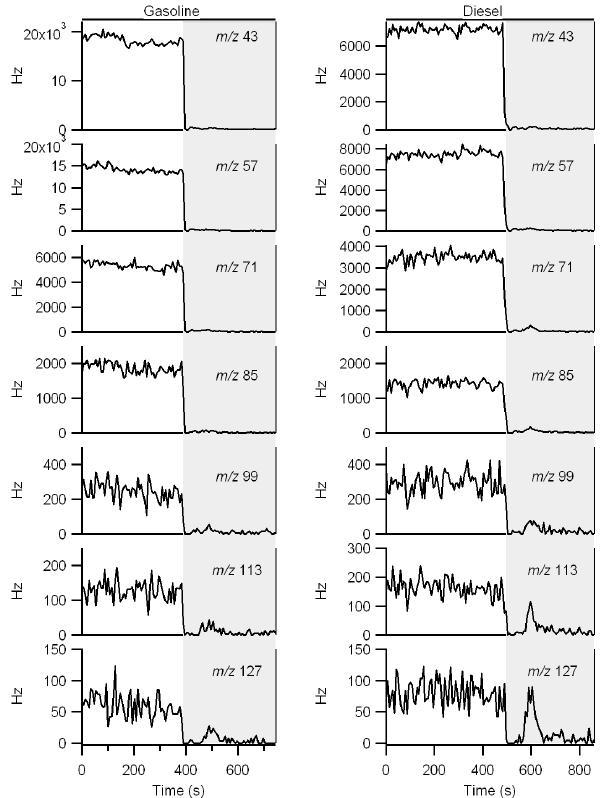
Fig. 9. Time series of measurements showing VOC and IVOC sig- nals in gasoline (left) and diesel (right) exhaust. The IVOC mode signal is indicated by the gray shaded area. The ion signal (Hz) is normalized to MHz H 3 O +